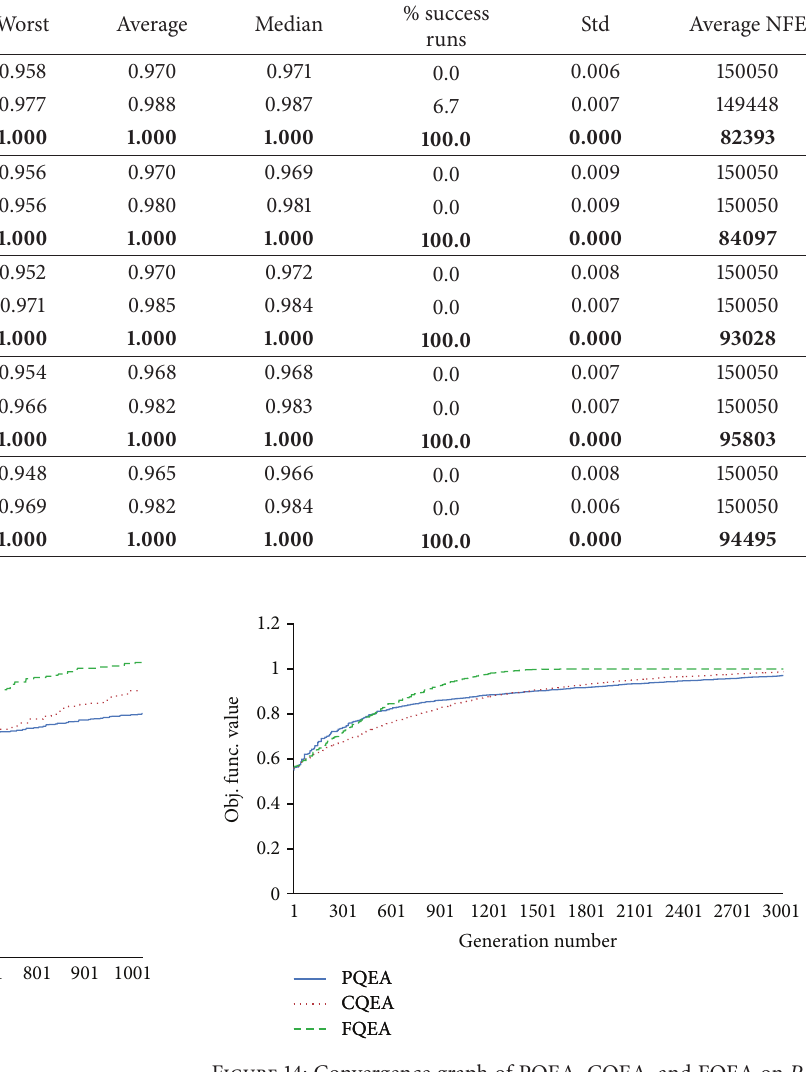
Figure 14: Convergence graph of PQEA, CQEA, and FQEA on 𝑃 - PEAKS problem of size, 𝑁 , being 1000 and number of peaks, 𝑃 , being